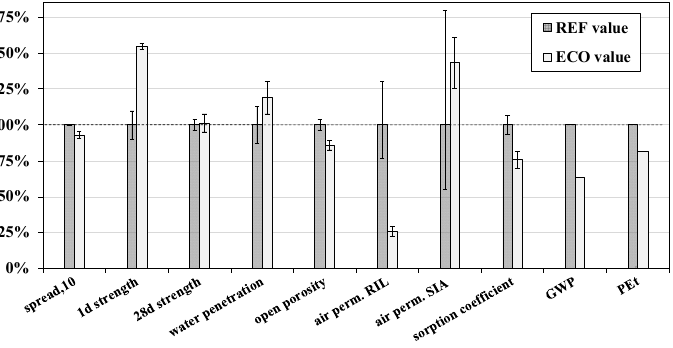
Figure 5. Normalized comparison of all investigated